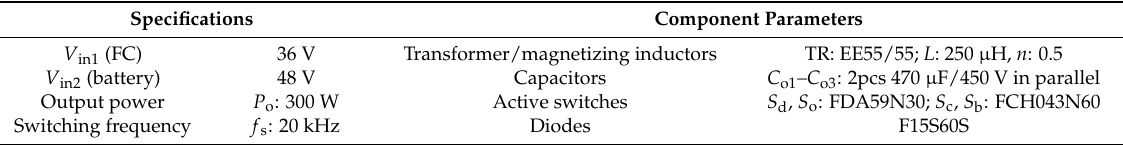
Table 1. Specifications/component parameters. FC: fuel cell.